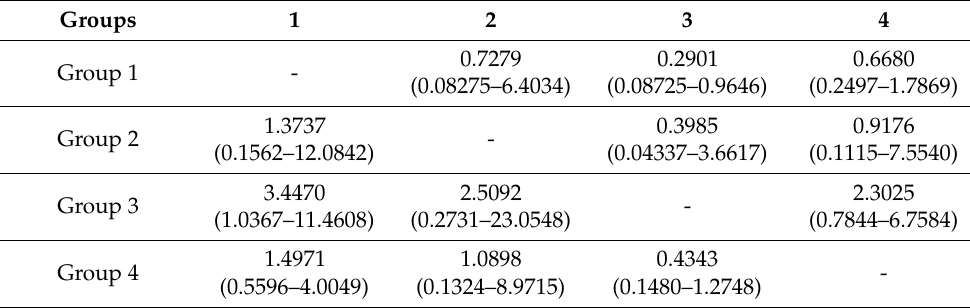
- 3.3. Disease Control Rate (DCR) Disease control rate (DCR) was defined as a complete plus partial response plus stable disease, and an overall response rate as complete plus partial response. Frequencies for all studied groups are summarized in Table 4. Patients from the control group had 2.80 HR times lower survival compared with the subjects on immunotherapy (95% CI, 1.11– 7.05), 2.56 HR times lower survival compared with the patients on chemotherapy who did not suffer from COVID-19 infection (95% CI, 1.00–6.55), and 1.49 HR times higher survival compared with the control group (0.43–5.17), as presented in Table 5. The difference in mortality was statistically significant between the groups p = 0.020. Results are presented in Figure 5. Table 4. Disease control rate (DCR) by analyzed groups of patients. Disease Control Rate